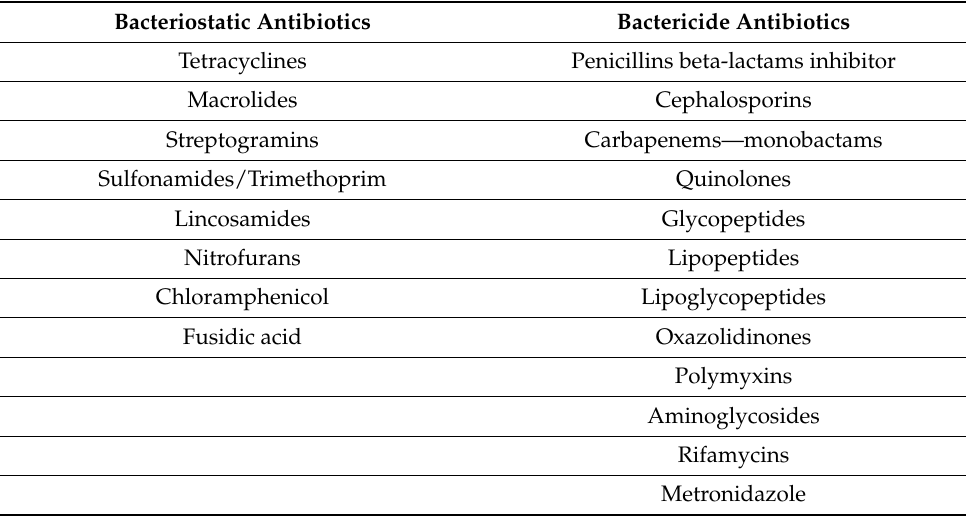
Table 1. Types of antibiotics according to the type of bacterial